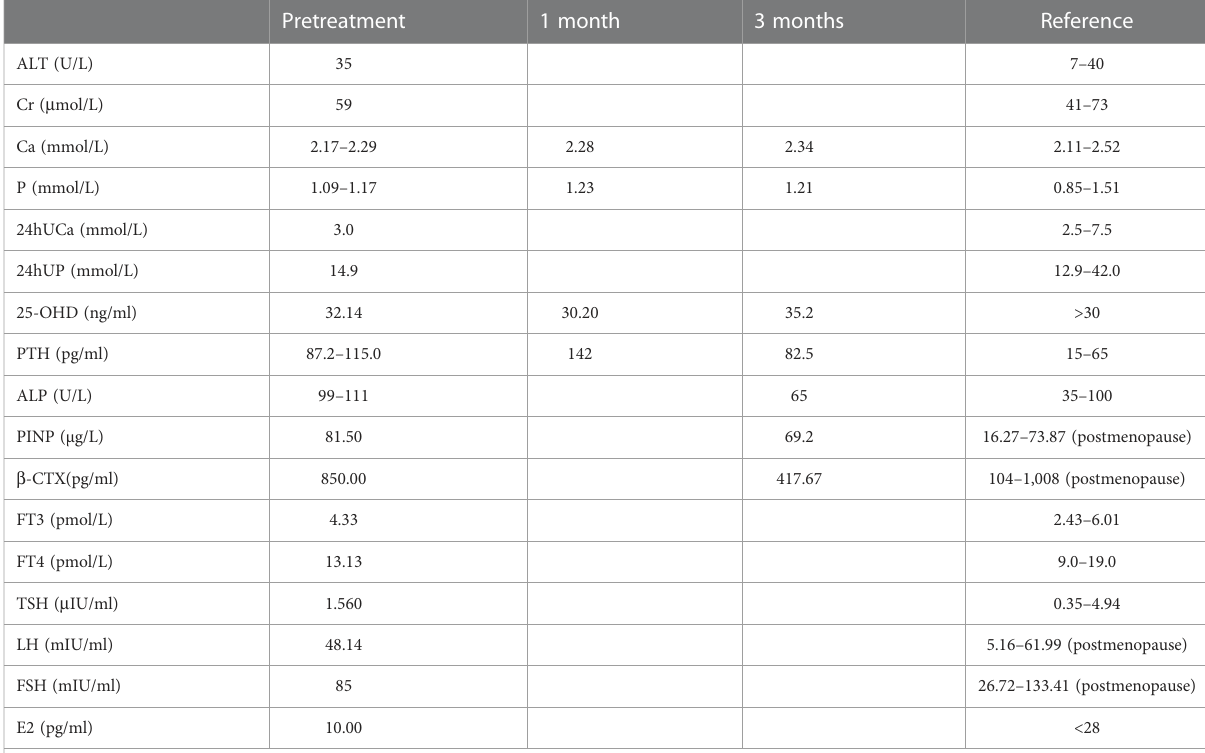
TABLE 1 Laboratory examinations before and after